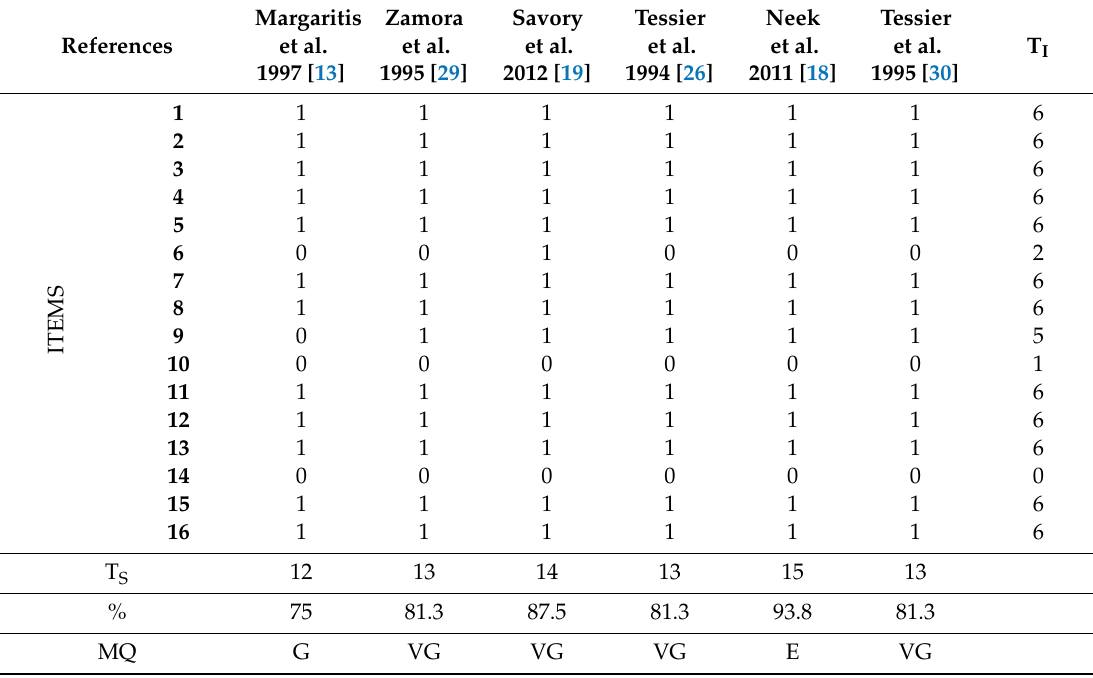
Table 2. Methodological quality of the studies included in the systematic